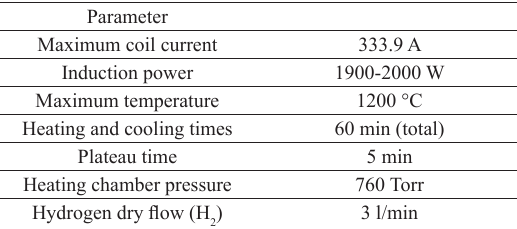
Table 1. Parameters for the tungsten cathode matrix pre-sintering step. Parameter